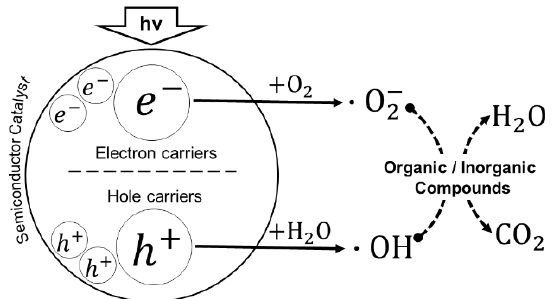
Figure 1. Schematic diagram showing the mechanism of heterogeneous photocatalysis of organic and inorganic compounds promoted by a semiconductor material.